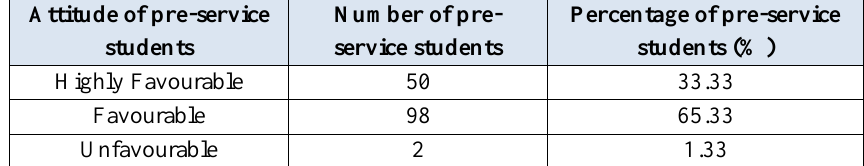
Table 5. Percentage of pre-service students in each category of attitude Attitude of